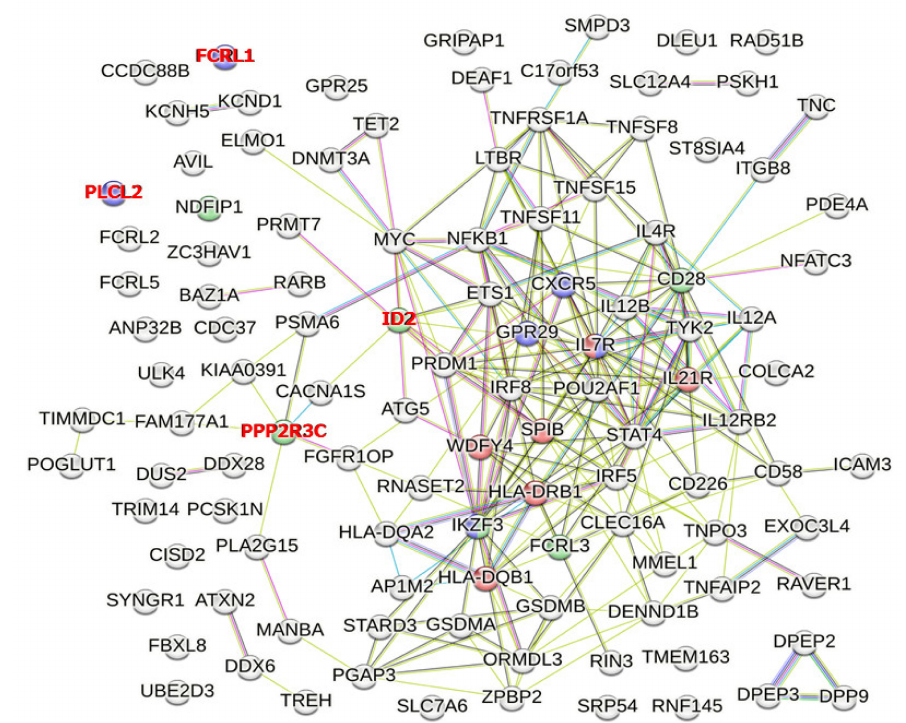
Figure 4. PBC susceptibility mapped genes and e-QTL genes whose protein products are involved in GO pathways related to “Activation, maturation, and differentiation of B cells.” Genes identified in the GO database as part of pathways associated with “Regulation of B cell activation (GO: 0050864),” “B cell activation (GO: 0042113),” and “B-lymphocyte cell line (BTO: 0001522)” are shown as blue, green, and red nodes, respectively. However, after removal of “the e-QTL genes but not the mapped genes” (gene names shown in red), “Regulation of B cell activation (GO: 0050864)” and “B cell activation (GO: 0042113)” in the Gene Ontology database did not reach a level of statistical significance when using PBC susceptibility genes